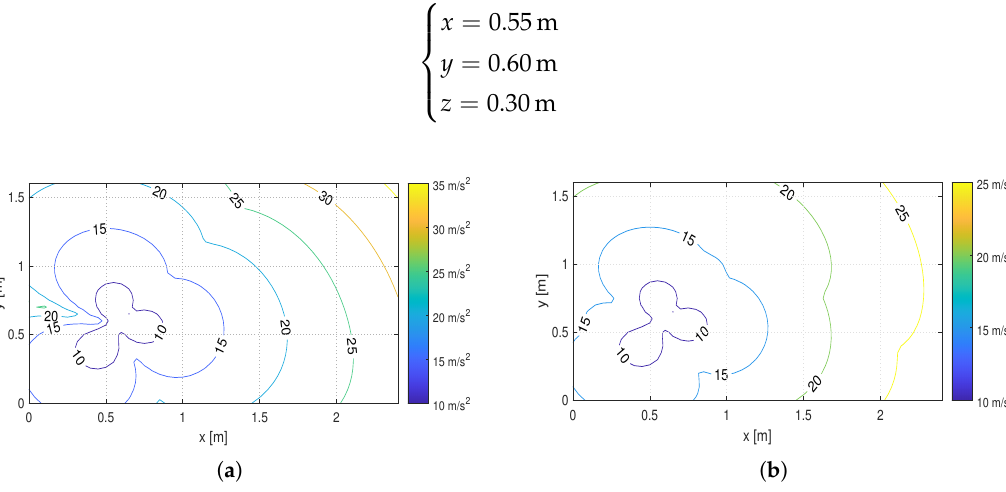
Figure 5. Comparison between the maximum acceleration limits obtained without considering the actuator dynamics ( a ) and considering the actuator dynamics ( b